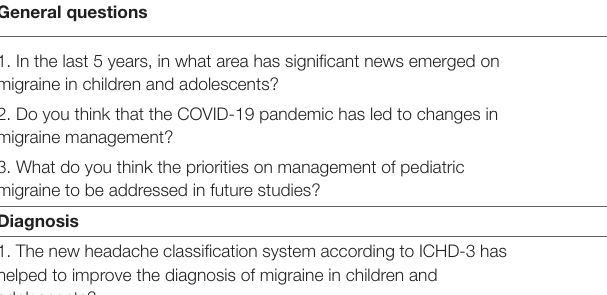
TABLE 1 | List of questions of the interview. General